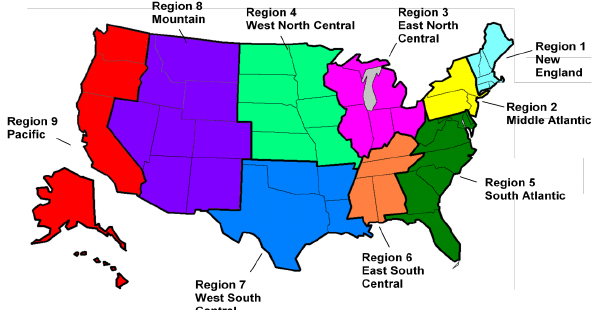
FIG 1 Fig. 1. The nine regions used within the US EPA MARKAL